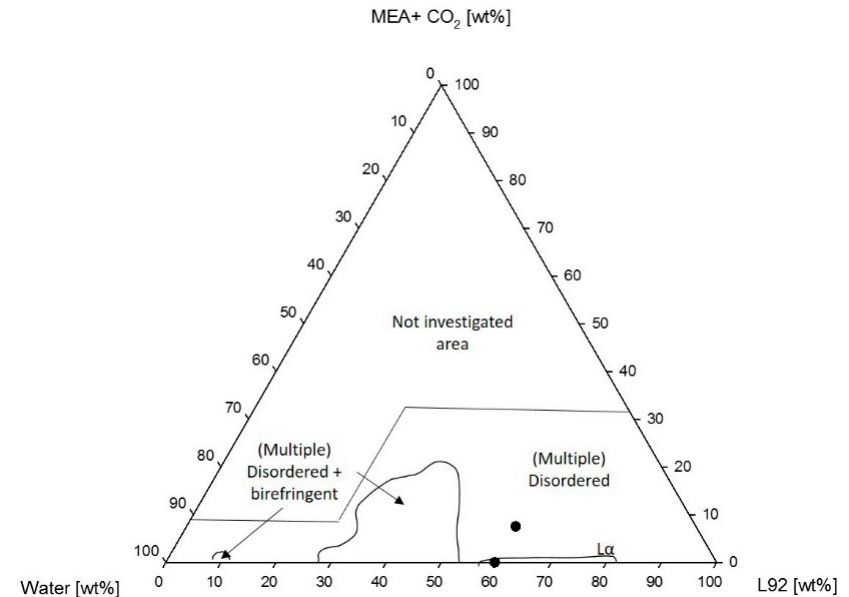
Figure 5. SAXS diffraction pattern obtained from a hexagonal phase of a sample with composition 75% L92/5% MEA. The peak positions follow the ratio 1: √ 3:2. Polymers 2018 , 10 , x FOR PEER REVIEW 7 of 15